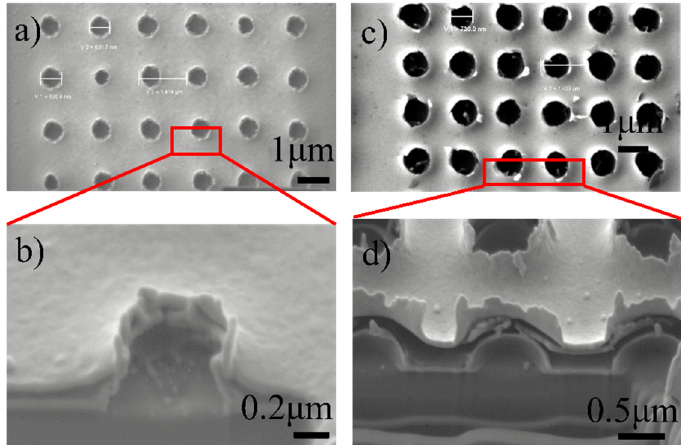
Figure 10. SEM images of periodic nanoholes in Au-MgF 2 -Au films ablated by fs laser: ( a ) fabricated by the fs laser beam with a smaller pulse energy of 7.8 nJ; ( b ) the cross section of the nanoholes of ( a ). ( c ) fabricated by the fs laser beam with a larger pulse energy of 26.4 nJ; ( d ) the cross section of nanoholes of ( c ).